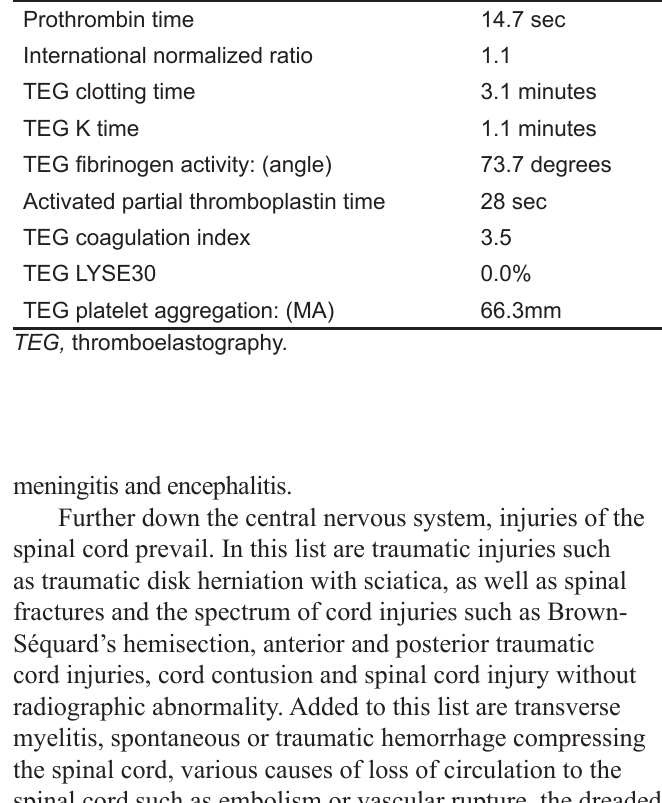
Table 2. Urinalysis and toxicology screen. Table 3. Coagulation studies and